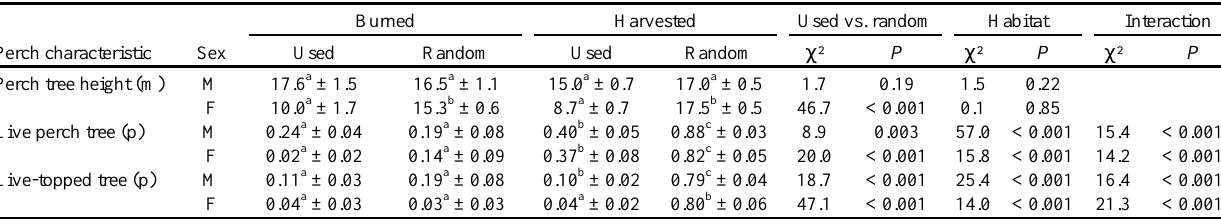
Table 2 . Comparison of characteristics of trees used as perches used by Olive-sided Flycatchers ( Contopus cooperi ) in northwestern Montana with randomly selected trees. Used perch trees are compared with randomly selected trees located outside of known breeding territories and as a function of habitat type (burned vs. selectively harvested forest). Each comparison is made separately for males (M, singing and foraging combined) and females (F). Wald c ² values and their associated P-values are derived from generalized estimating equation models. Marginal mean values are given for perch tree height in meters. The marginal probabilities (p) of a perch tree being (1) partially alive vs. entirely dead (a snag) and (2) having a minimum 0.5 m dead portion at its apex are given. Used/unused values for a focal sex and perch characteristic that share a superscript letter are not significantly different. Parameter estimates are given with their standard errors. Burned Harvested Used vs. random Habitat Interaction Perch characteristic Sex Used Random Used Random Perch tree height